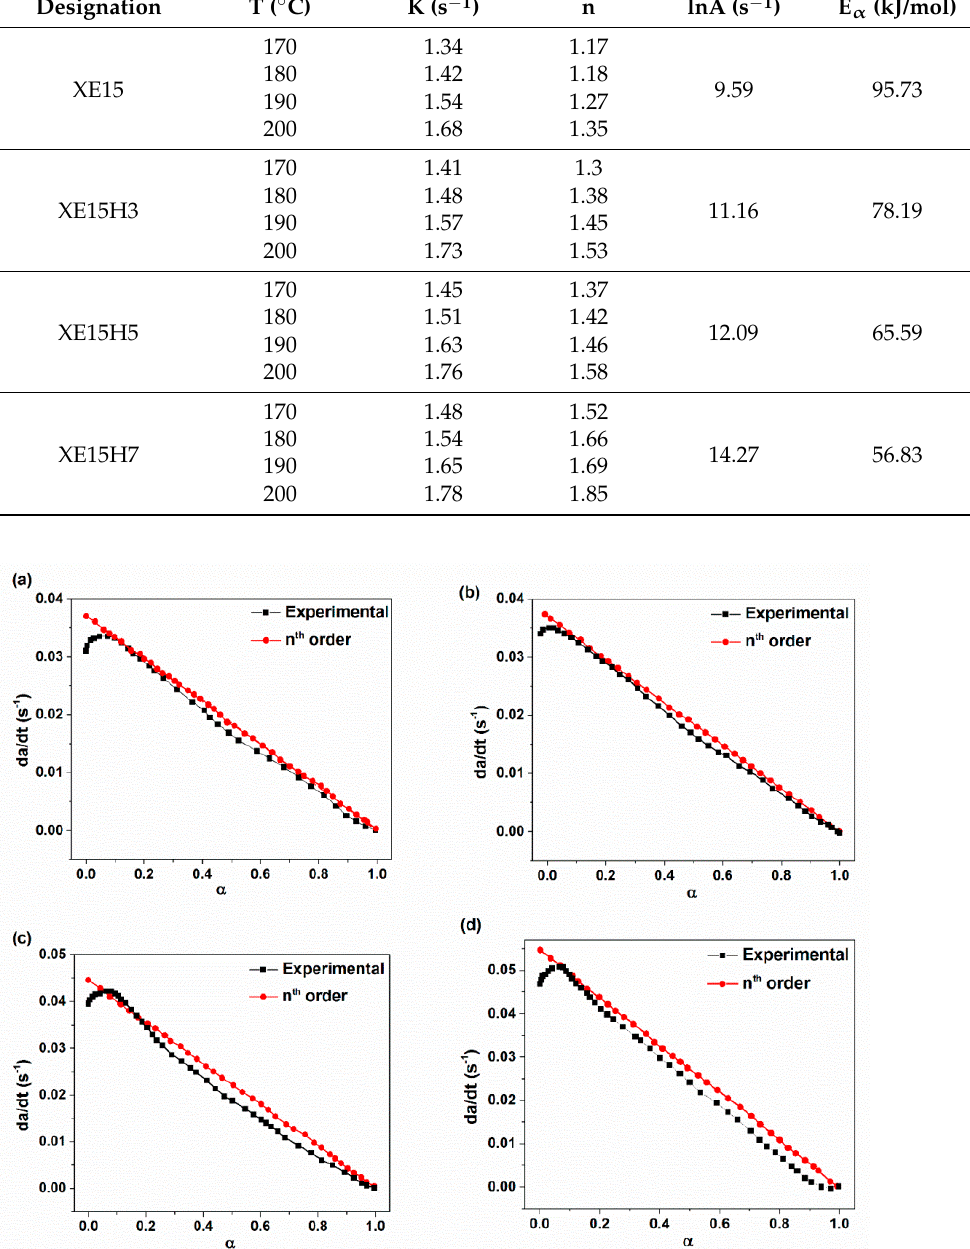
Figure 7. Comparison of experimental conversion rate with predicted ones through using n th order model with respect to cure conversion parameter for: ( a ) XE15; ( b ) XE15H3; ( c ) XE15H5; ( d ) XE15H7.